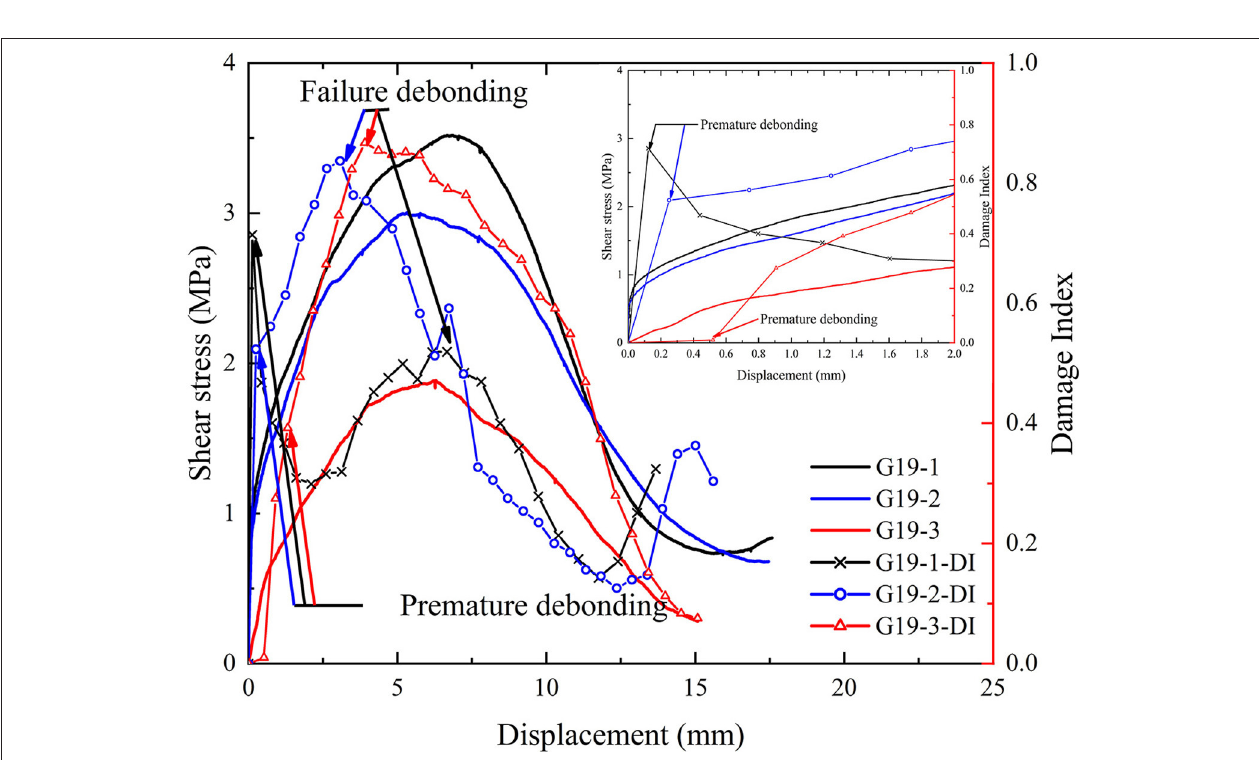
FIGURE 13 | Damage Index and bond-slip curves of